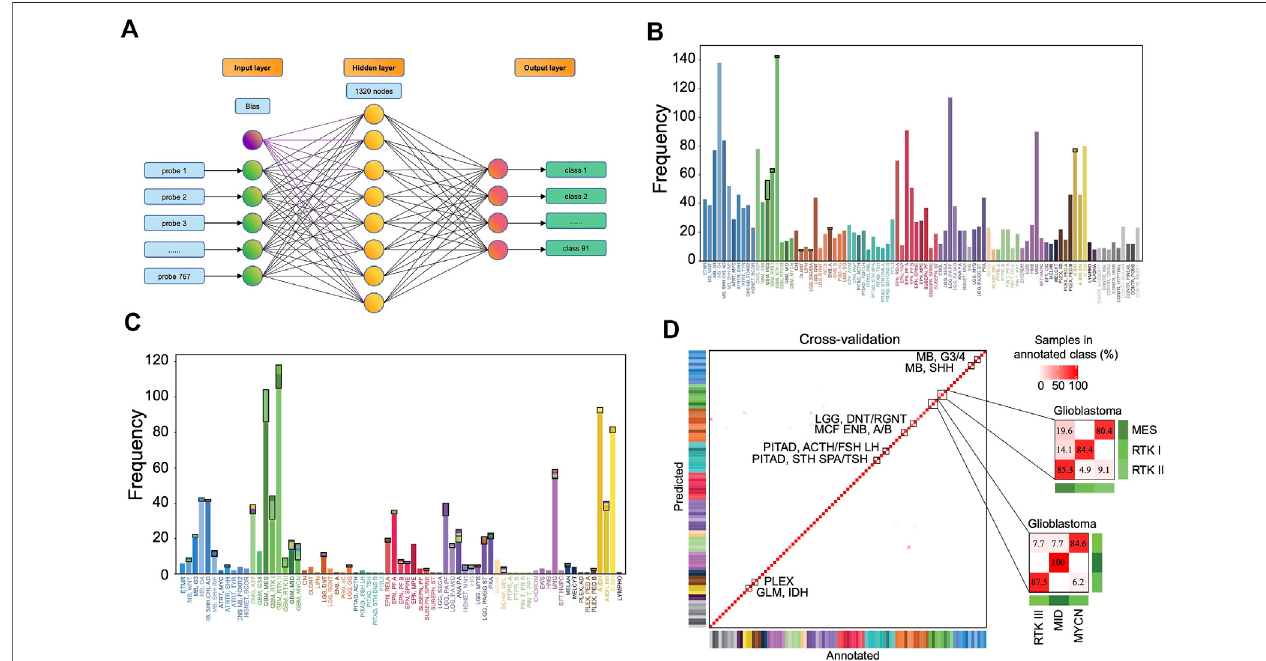
FIGURE4| Classi fi cationperformanceoftheMLPmodel. (A) Thethree-layerperceptronmodelstructure.Theinputlayerconsistsof767nodes,correspondingto 767 features. The hidden layer has 1,320 nodes, and the output layer has 91 nodes corresponding to 91 classes. Distribution of the prediction results in the training set (B) and in the validation set (C) . Each column represents one tumor class. The bottom parts represent the correctly predicted results and the top parts enclosed by a black rectangle represent the incorrect results where the colors correspond to the predicted classes. (D) Heat map showing results of a 5-fold cross-validation of the MLP classi fi er in the training set, which incorporates the result allocated to 91 methylation classes of all 5-iterations. The diagonal data cells represent classi fi cation accuracies while the off-diagonal cells represent the misclassi fi ed rates. For example, 45 of the 56 “ GBM, MES ” samples were correctly classi fi ed (80.4%), and 11 samples were misclassi fi ed as “ GBM, RTK II ” (19.6%). The color ofannotation and abbreviations can refer to Figure 2 . Methylation class families (MCF) are indicated by black